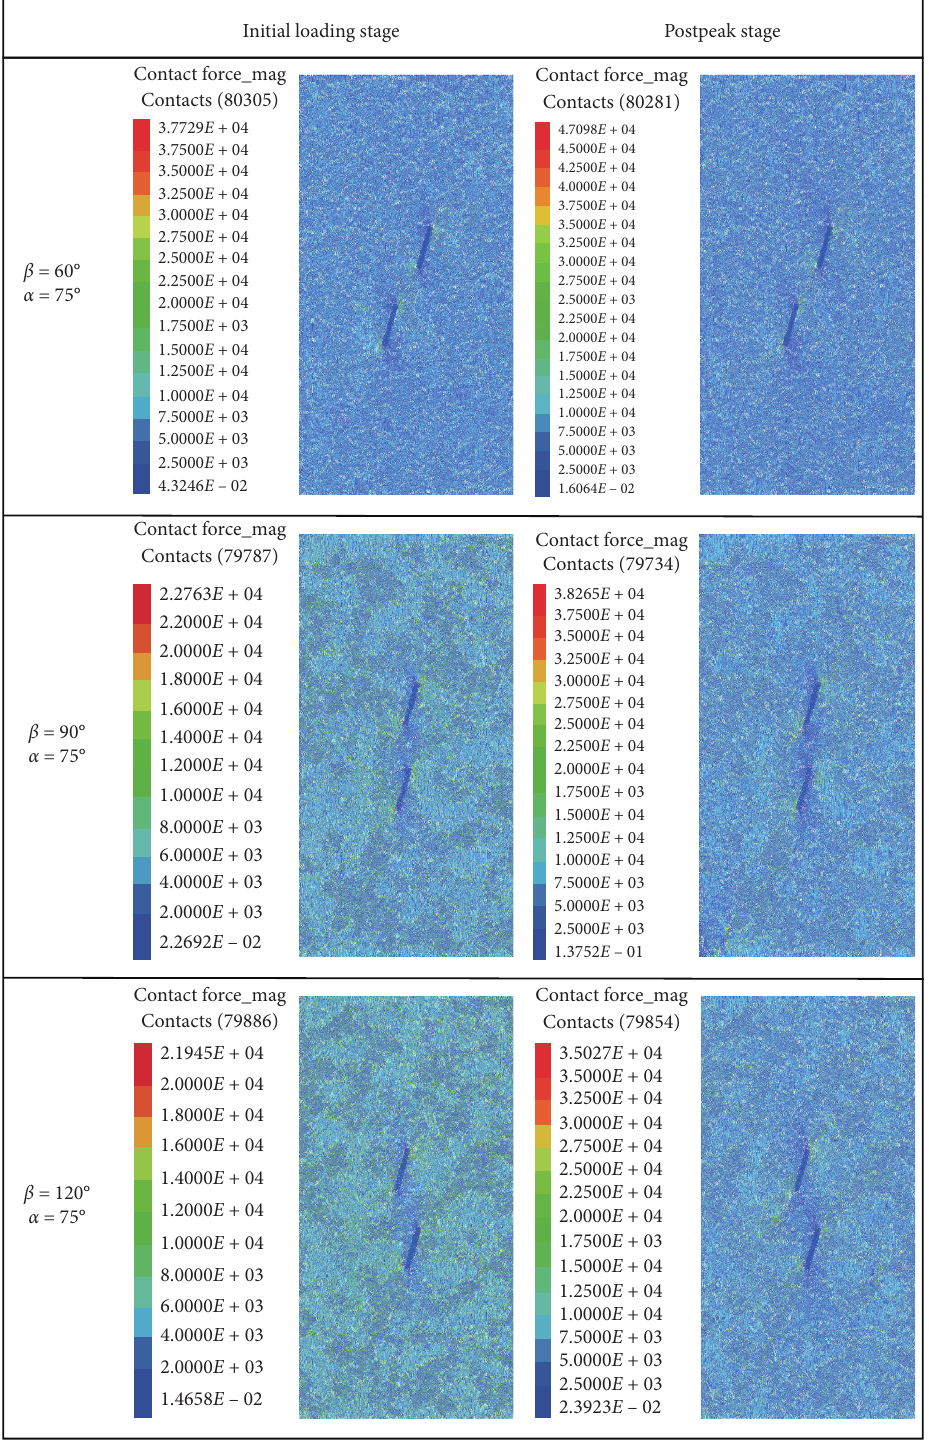
Figure 11: Contact force of samples containing infilled flaws with the same α of 75 ° and different β of 60 ° , 90 ° , and 120 °